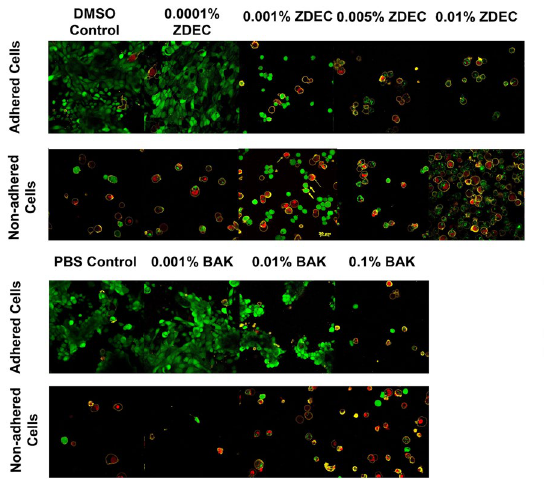
Figure 1. ZDEC and BAK exposed HLEC confocal laser scanning micrographs. Representative confocal laser scanning micrographs showing the effect of the different concentrations of ZDEC and BAK on the viability of the HLEC stained with calcein-AM (green), ethidium homodimer-1 (red), and annexin V (yellow). In addition to the identification of the dye based on their color the dyes’ location also identifies the presence of each dye as well. The calcein dye stains the cytoplasm of the cell and results in typically a uniform distribution throughout the cytoplasm in live cells without compromised membranes. Because ethidium homodimer-1 stains nucleic acid the stain is either centered at the nucleus of the cell or, if the cell is in a later stage of cell death, results in diffuse non-uniform staining of nucleic acid in the cell. Annexin V stains only the cell membrane of the cell. Scale bar is the yellow bar center